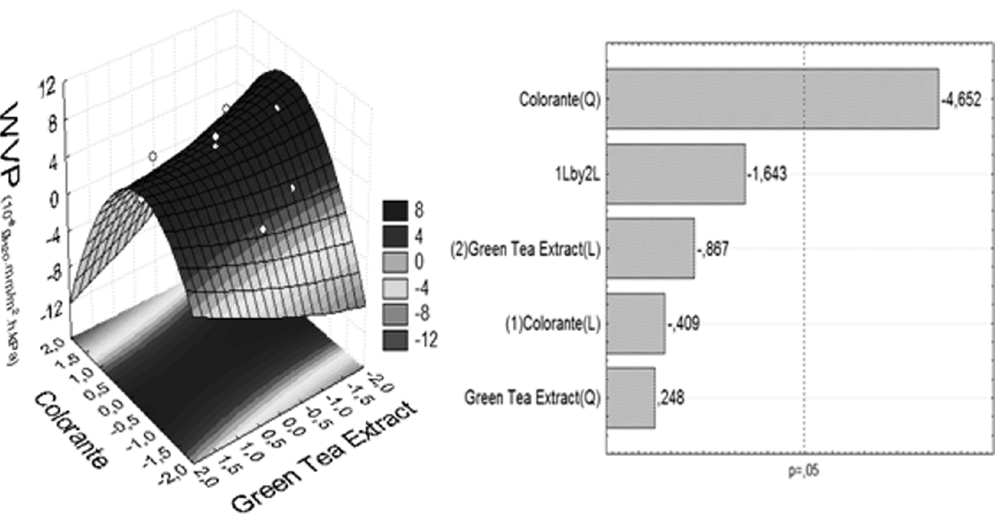
Figure 2. Response surface plot and Pareto chart for understanding water vapor permeability (WVP), as function on the content of colorant and GTE, with additives coded values ( X 1 e X 2 ).